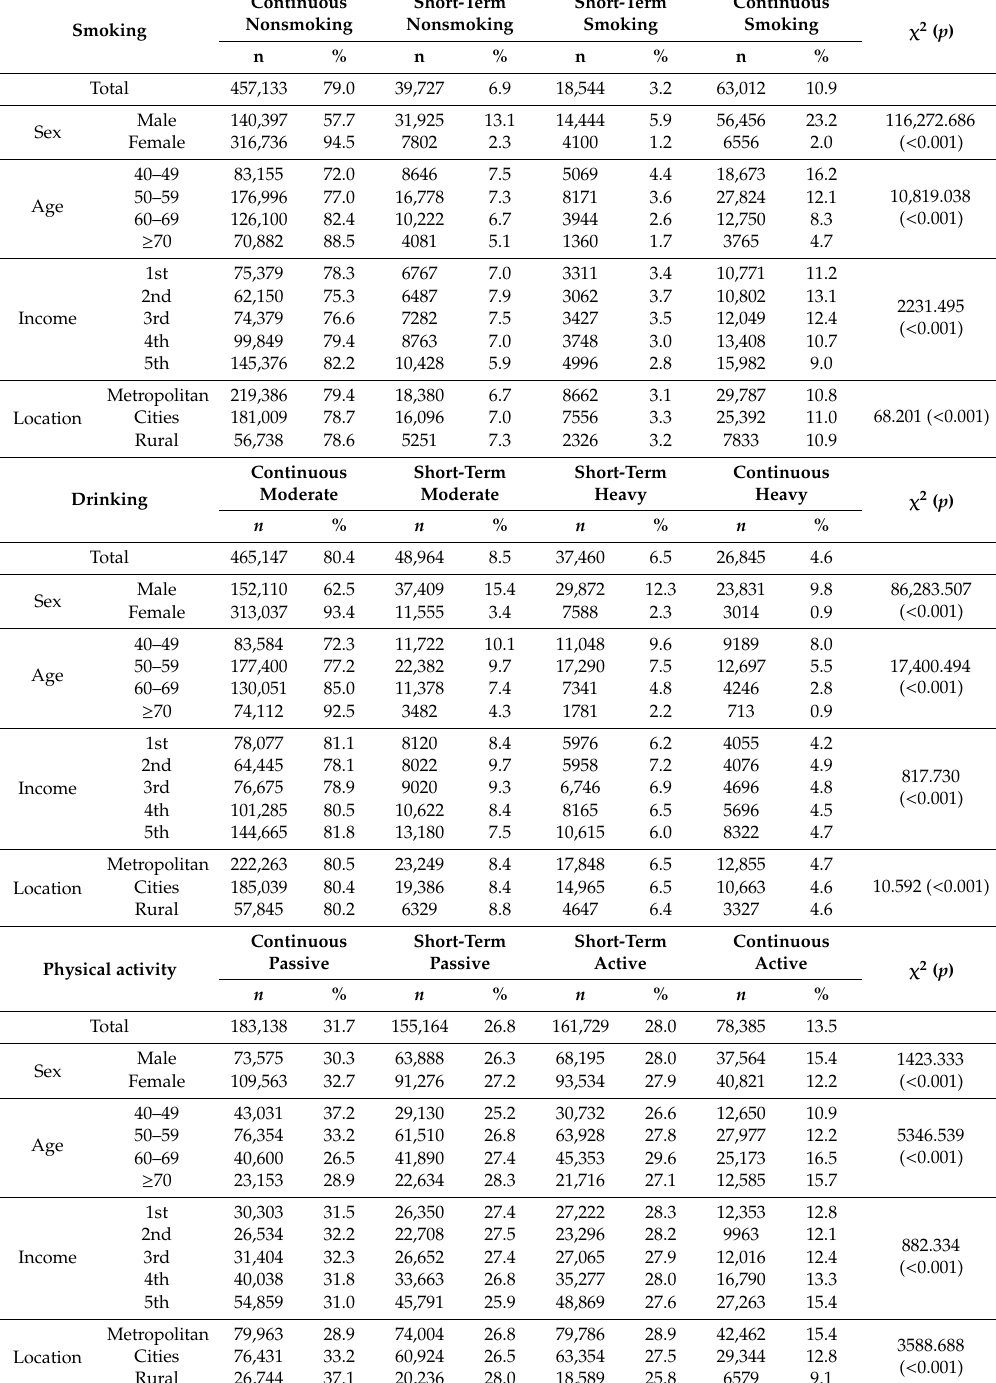
Table 3. Trend of changes in health-related behavior change by general